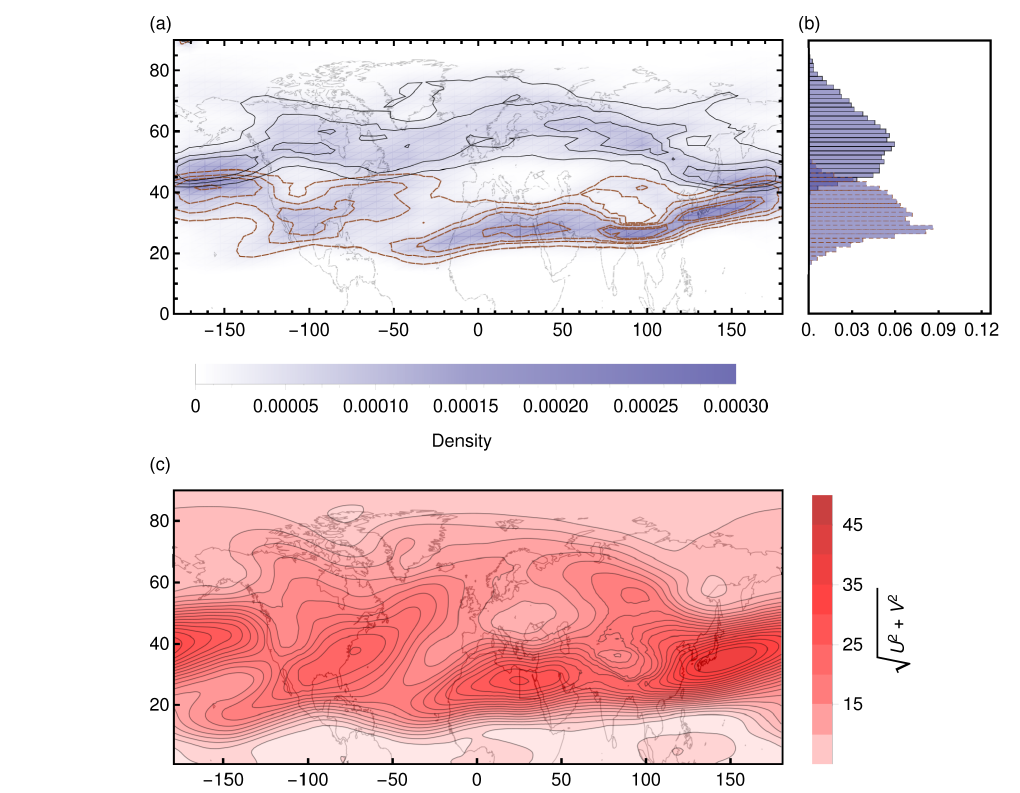
Figure 10. Probability analysis for spring months (MAM): Panel (a) and (b) show the spring probability density plot and a histogram of the jet stream occurrences (1979–2014). The brown dashed contour lines represent the subtropical jet stream, whereas the black solid contour lines represent the polar jet stream. Panel (c) depicts the climatological annual wind field (averaged over 1979–2014).